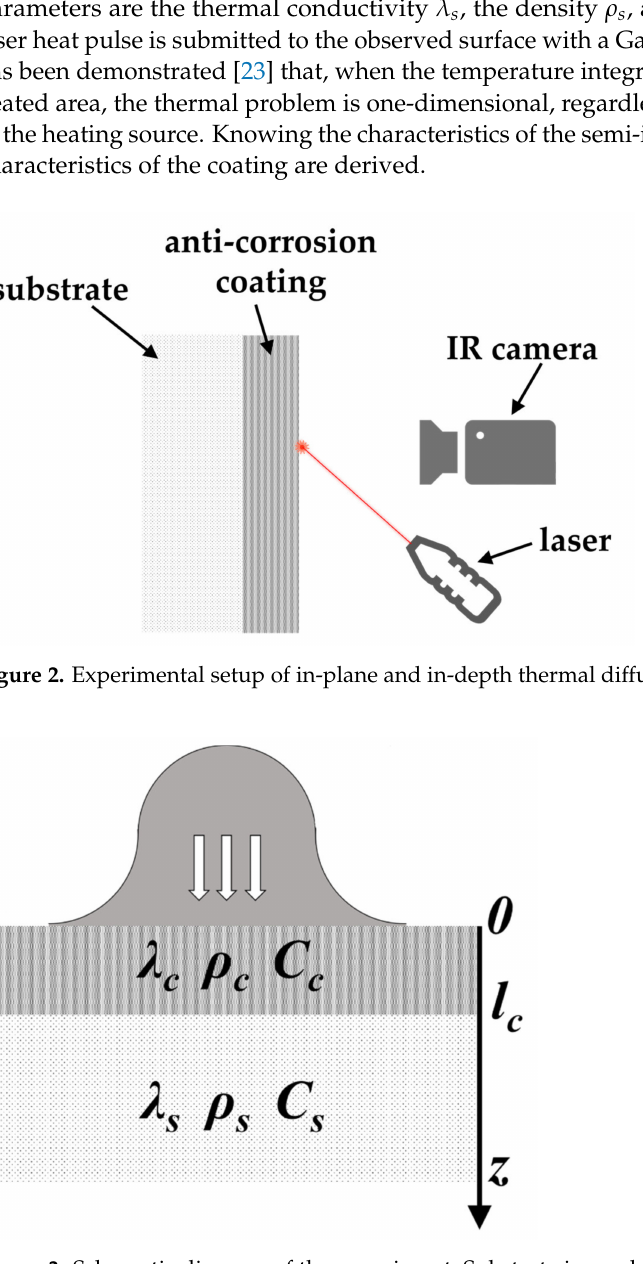
Figure 3. Schematic diagram of the experiment. Substrate is much thicker than the coating and is considered endlessly extended along the z -axis. On the observed surface, a laser heat pulse is released with a Gaussian spatial distribution